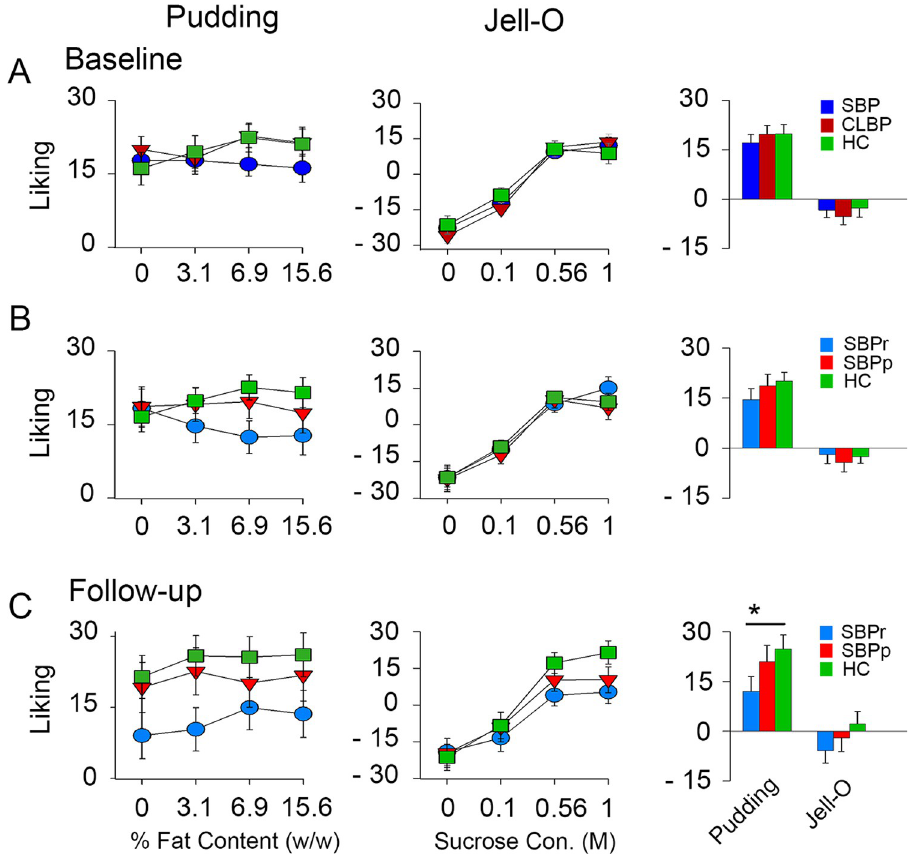
Fig 3. Psychophysical ratings (liking) during session 1 at baseline and follow-up. ( A ) shows results for SBP (n = 51), CLBP (n = 43 for pudding and n = 41 for Jello) and healthy control subjects (n = 36) at baseline; ( B ) shows results for SBPr (n = 20), SBPp (n = 16) and HC (n = 36) at baseline; and ( C ) for SBPr (n = 15 for pudding and n = 13 for Jello), SBPp (n = 13) and HC (n = 16 for pudding and n = 14 for Jello) at follow-up. ( A–C ) ( Left ) Participants’ ratings for each of the 4 fat concentrations of puddings. ( Middle ) Ratings for each of the 4 sucrose concentrations of flavored Jello. (Far right) Bar plot depicting mean ± standard error of the mean (SEM) across all the concentrations for pudding (left) and jello ( Right ). No significant difference were found among groups. Adding covariates, including pretest hunger rating and sex, did not alter the main results. ratings of the preferred pudding collected during session 1 predicted caloric intake when par- ticipants came back for pudding consumption during session 2 as we previously studied [17]. Liking of preferred pudding predicted significantly caloric intake in HC (r = 0.60, p = .001) but not in SBP (r = 0.14, p = 0.40) or CLBP patients (r = 0.13, p = 0.49), indicating, as hypothe- sized, that the relationship between liking of food and caloric ingestion is absent in the patients’ groups ( Fig 5A ). SBPr, SBPp and HC groups’ total caloric consumption from preferred puddings did not sig- nificantly differ at baseline (p = 0.44), or follow-up (p = 0.22) ( Table 4 ). Interestingly, at base- line the prediction of caloric intake from the magnitude of liking ratings of the most preferred pudding sampled during session 1 was close to significance and stronger in the at risk SBPp patients (r = 0.38, p = 0.16, Fig 5B right ) than in SBPr patients (r = - 0.14, p = 0.53, Fig 5B middle ). This picture persisted at follow-up. As such, the prediction of caloric intake from the magnitude of liking ratings was close to significance in SBPp patients, (r = 0.52, p = 0.08, Fig 5C right ) but was weaker and was not statistically significant in SBPr patients (r = 0.21,